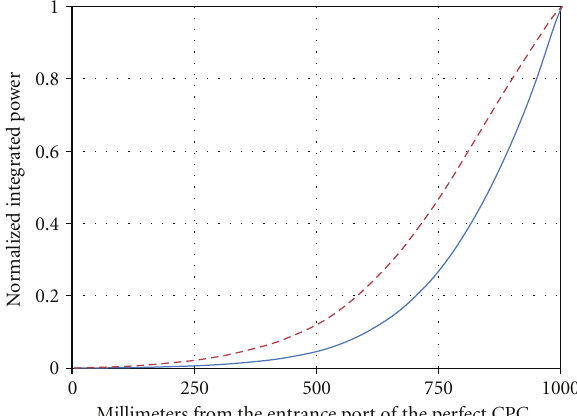
Figure 7: Comparison between simple power-approximation method (solid line) and corrected-power approximation method (dashed line). The lines refer to the normalized integral power inci- dent on a small longitudinal section of the ideal CPC coplanar to the CPC axis (solid line) and to the same integral function after correc- tion according to the corrected-power approximation method (dashed line).